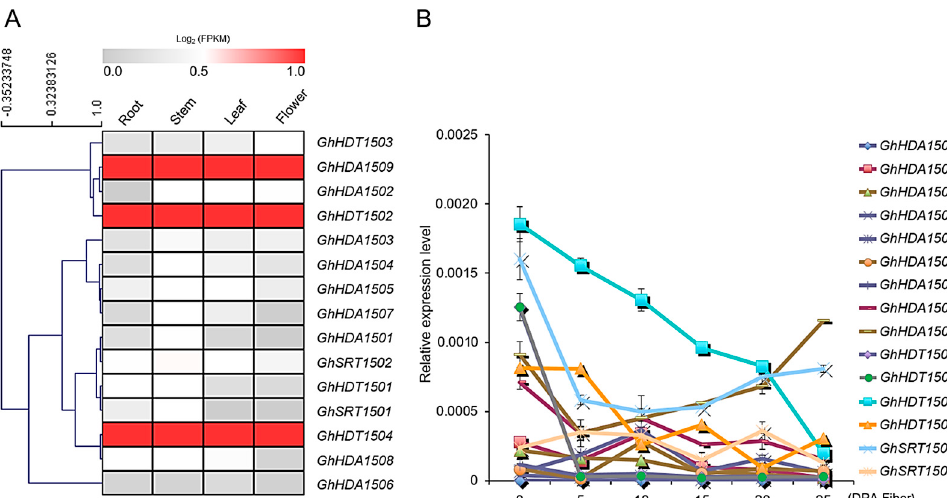
Figure 5. Gene expression validation of G. hirsutum HDACs using qRT-PCR in different tissues ( A ) and at different stages of fiber development ( B ). RNA from root, leaf, stem, flowers and different stages of fiber development were extracted and reverse transcribed. qRT-PCR was performed and the data was normalized to UBQ7 . The relative gene expression in different tissues is presented in the heatmap. The data presented are the average of three biological replicates; the bar represents the standard deviation.